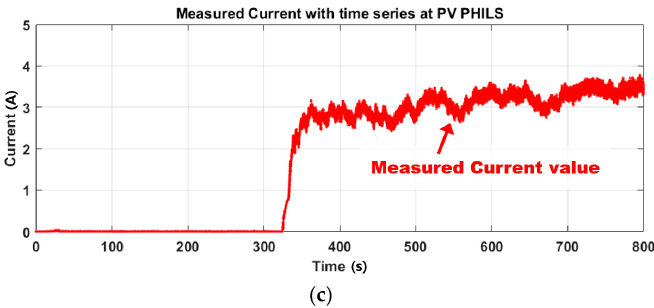
Figure 14. Experiment result with proposed advanced operation algorithm of PV PHILS. ( a ) I-V Curve characteristic graph of the PV System ( b ) DC power supply voltage output with time series ( c ) DC power supply current output with time series.